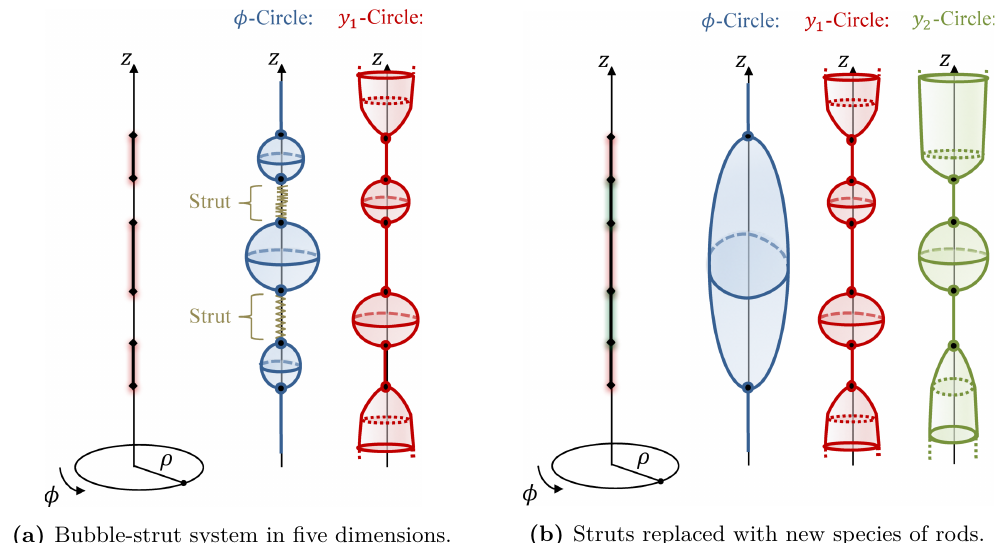
Figure 1. In figure 1a, there are multiple rod sources along the z -axis of three dimensional cylindrical base. Each rod source corresponds to a region where the KK circle with coordinate y collapses defining a bubble locus. The struts are segments where the base circle shrinks. Solutions with arbitrary chain of struts and bubbles can be constructed. In figure 1b, we add a new circle and substitute the struts with a new species of rod sources. This leads to a smooth topological structure that grows with the number of rod